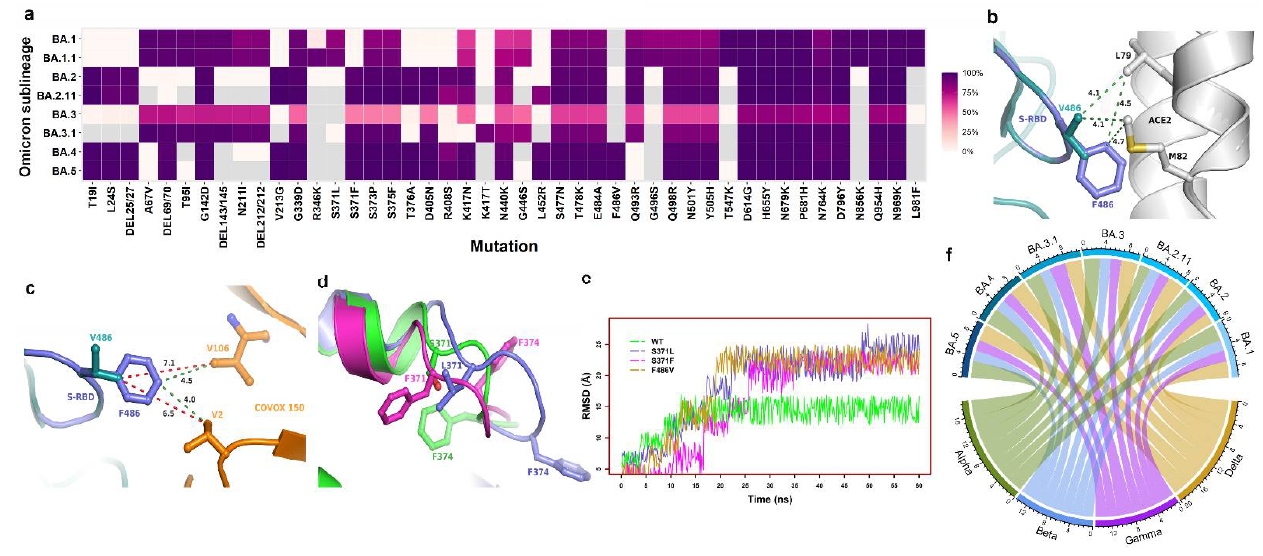
Figure 3. Prevalence of mutations in Omicron sublineages and their structural impacts: ( a ) An example of the mutation patterns in different Omicron sublineages. Sublineages BA.1.1 and BA.2.11 are included here to show that there exist inter-sublineage differences in the mutations. Sublineage B.1.1 has an R346K mutation that is not present in B.1 and Omicron (B.1.1.529). Similarly, BA.2.11 has an L452R mutation that is not present in BA.2. ( b ) The location and interactions of F486/V486 with ACE2. This figure was generated from PDB entry 7ZF7 [21]. The WT (Wuhan-Hu-1) S-RBD is shown as violet ribbons, whereas ACE2 is colored grey. The amino acid residues are rendered as ball-and-stick models. The carbon atoms in this and subsequent panels are colored in the same colors as the ribbons, whereas sulfur atoms are shown in gold and nitrogen in blue. V486-containing S-RBDs (as in BA.4 and BA.5) are shown in teal, as are the carbon atoms. The green dotted lines represent the distance between the F486/V486 and ACE2 residues. ( c ) The impact of the F486V mutation on mAb binding. This figure was generated from PDB entry 7ZF8 [21], representing the binding of the BA.2 S-RBD with the COVOX 150 antibody. The V486 mutation is shown in teal and the amino acid residues of COVOX 150 are shown in orange. ( d ) The change in the conformation of the loop containing S371 in WT (green), L371 in BA.1 (deep blue), and F371 in BA.2 (magenta). It is clear from the position of F374 (located on the same loop) that the loop conformation is altered significantly, depending upon the omicron sublineage. ( e ) The trajectory of the root-mean-square deviation of S-RBD C α -atoms in WT, S371L, S371F, and F486V over 60 ns MD simulations. ( f ) A chord diagram shows common mutations between selected Omicron sublineages and the Alpha, Beta, Gamma, and Delta VOCs. The thickness of the end of the chord represents the number of mutations (two or